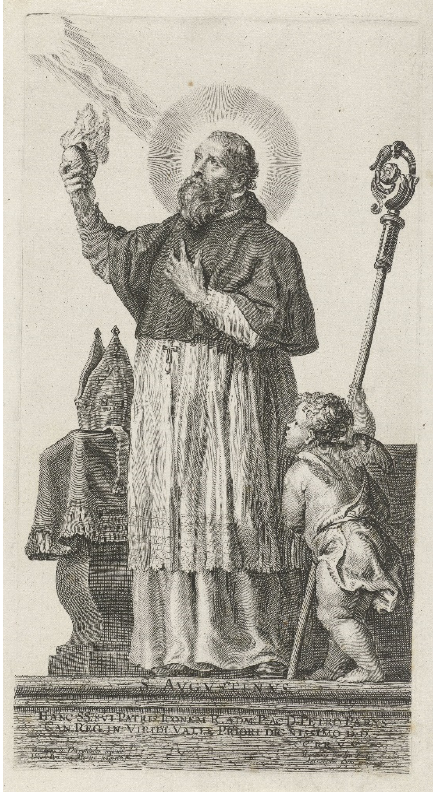
Figure 16. Theodor van Merlen II (1609–1672), after Abraham van Diepenbeeck (1596–1675), H. Augustinus , 1619–1672, engraving, 259 mm × 136 mm. Credit line: Rijksmuseum.